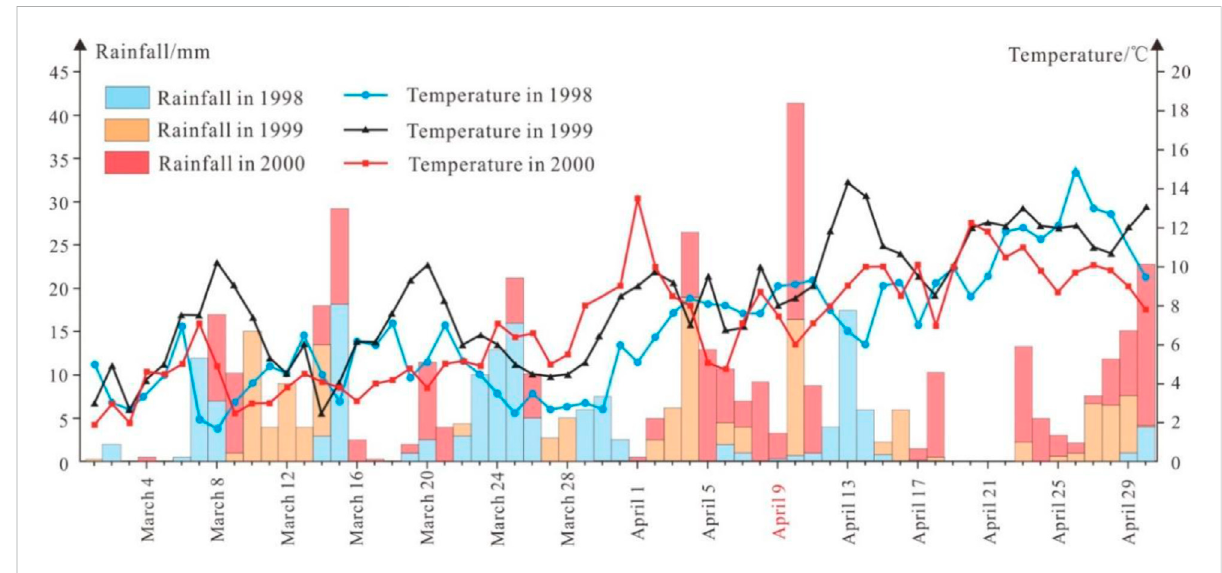
FIGURE 8 Statistics of rainfall and temperature in the Yigong area from March 1 to 30 April 1998, 1999 and 2000 (modi fi ed after Zhou et al.,